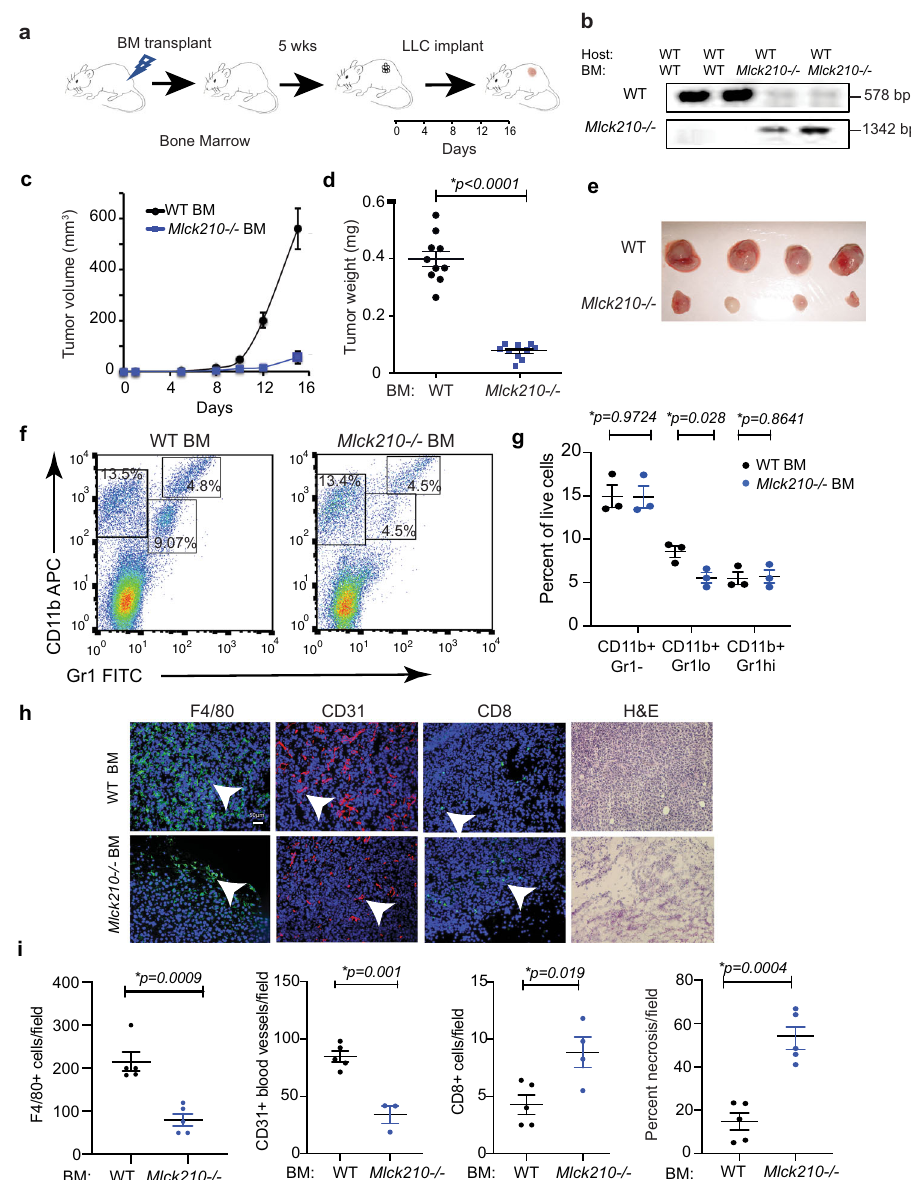
Fig. 7 Deletion of bone marrow cell MLCK210 inhibits tumor growth. a Schematic of bone marrow transplantation and tumor implantation. b Genomic PCR to detect Mlck 210 gene in peripheral blood cells from BMT transplanted mice ( n = 2 mice). c – e Tumor volumes ( c ), weights at endpoint (15 days) (*p < 0.0001 WT vs Mlck210 − / − BM) ( d ) and images of gross tumor morphology ( e ) from LLC tumors in WT mice transplanted with bone marrow from WT ( n = 10 mice) or Mlck210 − / − mice ( n = 10 mice). f Representative FACS pro fi les and g quanti fi cation of Gr1-CD11b + ( p = 0.9724) Gr1loCD11b + (*p = 0.0280), Gr1hiCD11b + ( p = 0.8641) myeloid cells in representative WT vs Mlck210 − / − BM transplanted tumors harvested at endpoint (15 days) ( n = 3 mice). For Facs gating scheme, see Supplementary Fig. 7b. h Representative histographs and i quanti fi cation of F4/80 + macrophages/ fi eld ( n = sections from 5 WT mice and 5 Mlck210 − / − ) *p = 0.0009, CD31 + blood vessels/ fi eld ( n = sections from 5 WT and 3 Mlck210 − / − mice) *p = 0.001, CD8 + T cells/ fi eld ( n = sections from 5 WT and 4 Mlck210 − / − mice) *p = 0.019 in tumor sections and 100X H&E-stained tumor sections to detect percent necrosis/ fi eld ( n = sections from 5 mice) *p = 0.0004 from mice transplanted with WT vs Mlck210 − / − bone marrow. Data are presented as mean values ± SEM. Signi fi cance testing was performed by Student ’ s t -test. Experiments were performed twice. Source data are provided with this article as a Source Data fi